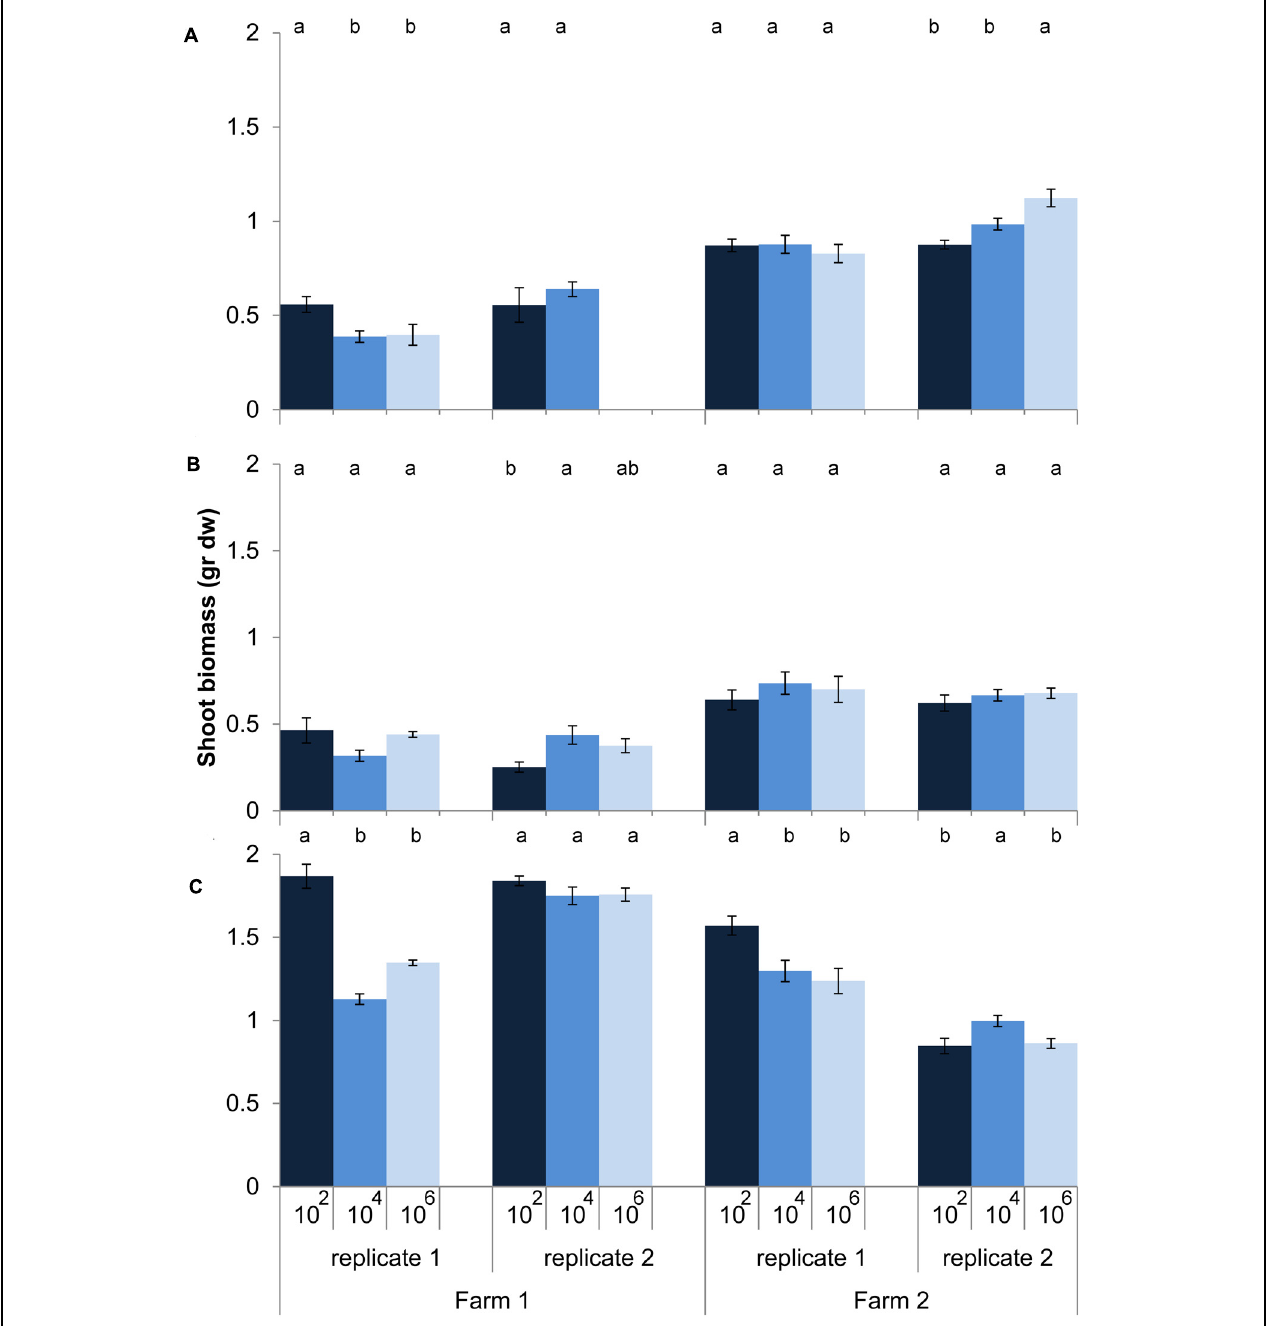
FIGURE 2 | Shoot biomass (average ± SEM) of Triticum aestivum after 8 weeks of growth in sterilized soils inoculated with diluted soil suspensions from two farms and three land use types: (A) arable intensive, (B) arable rotation, and (C) pasture. The color of the bars